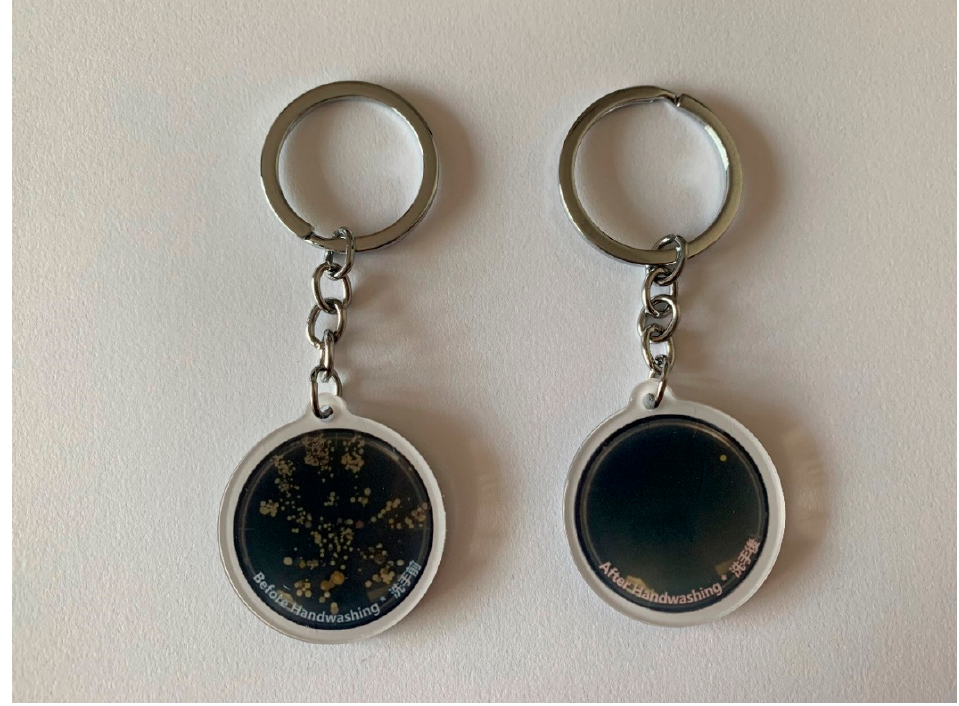
Figure 6. Key chain with handprint photos.